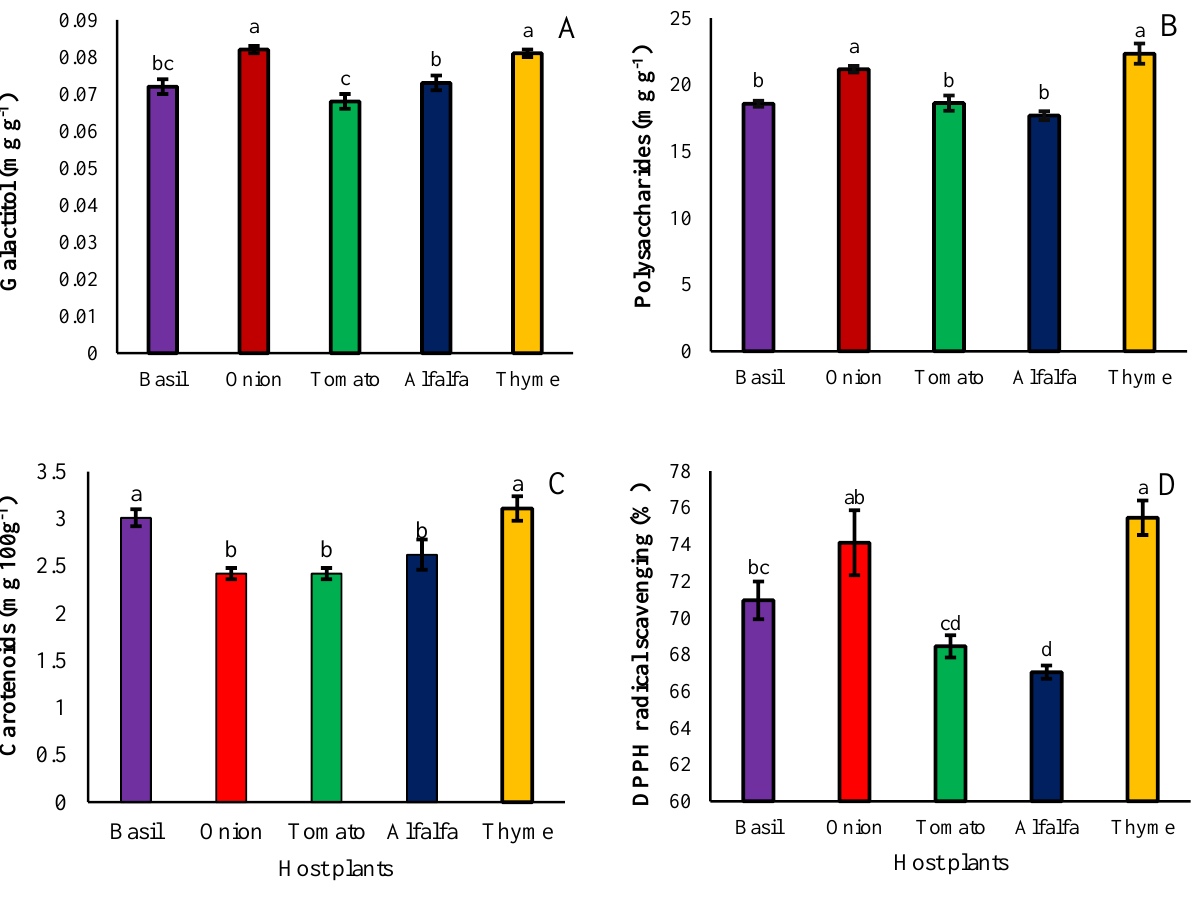
Figure 5. The effect of different hosts on the galactitol ( A ), total polysaccharides ( B ), carotenoid content ( C ), and DPPH radical scavenging ( D ) of the Cuscuta campestris seed set on different hosts. Bars with the same lowercase letter are not significantly different at p ≤ 0.05 for n = 3.